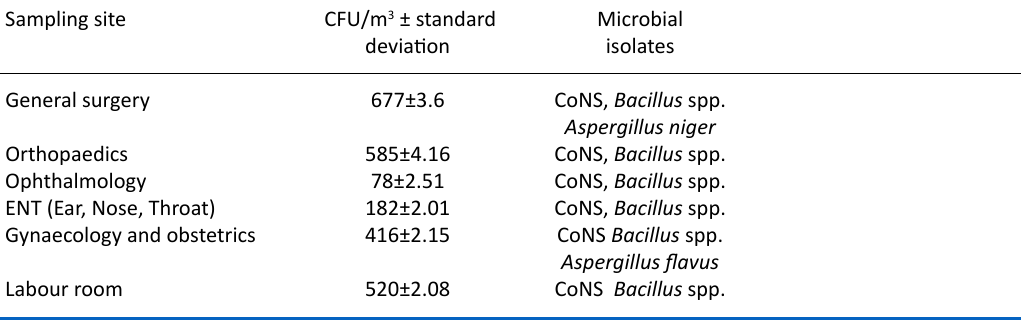
table 4. Various isolates from air sampling and their colony forming unit count from OTs and LR Sampling